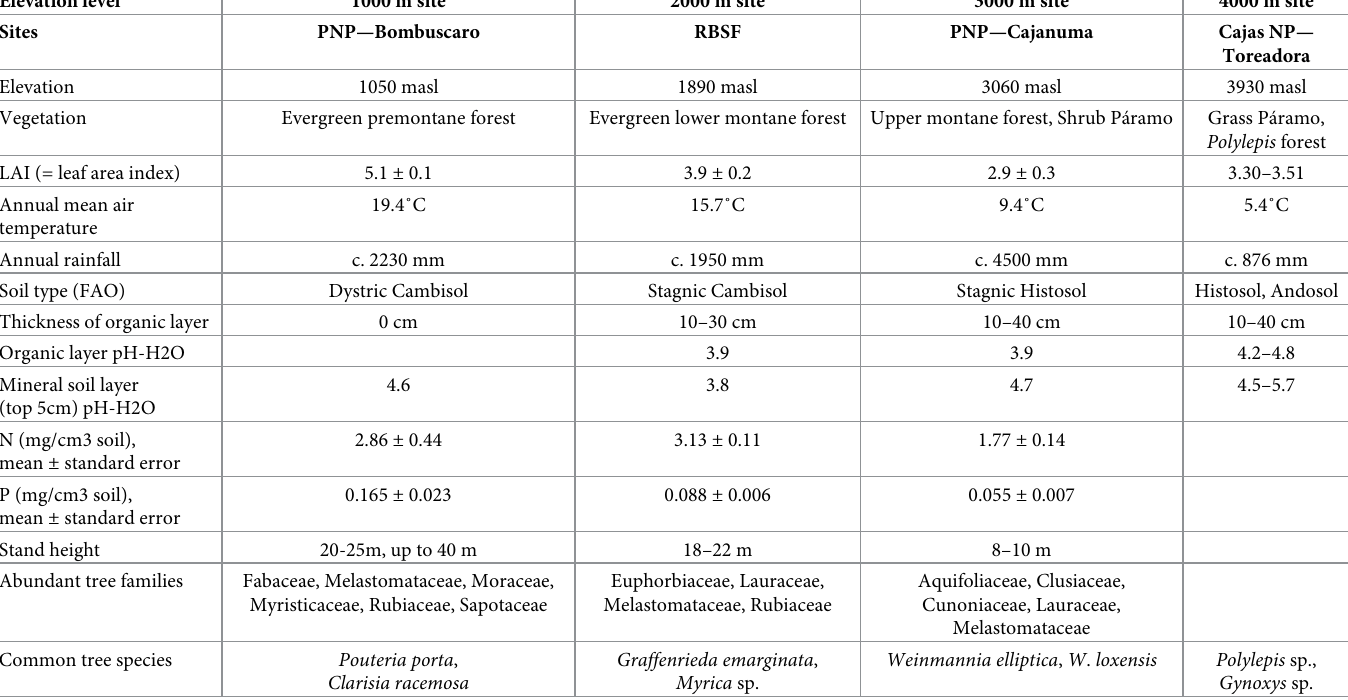
Table 1. Site characteristics for the four elevation